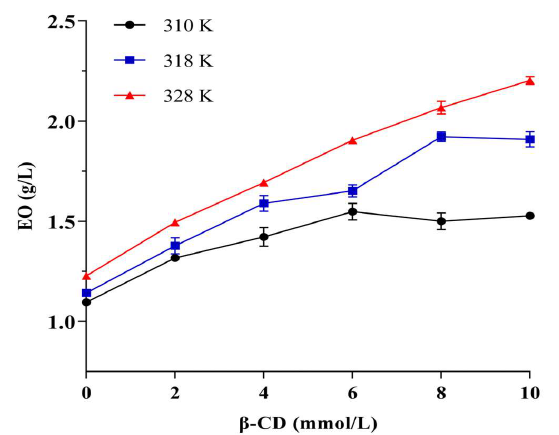
Figure 7. The result of phase solubility study.